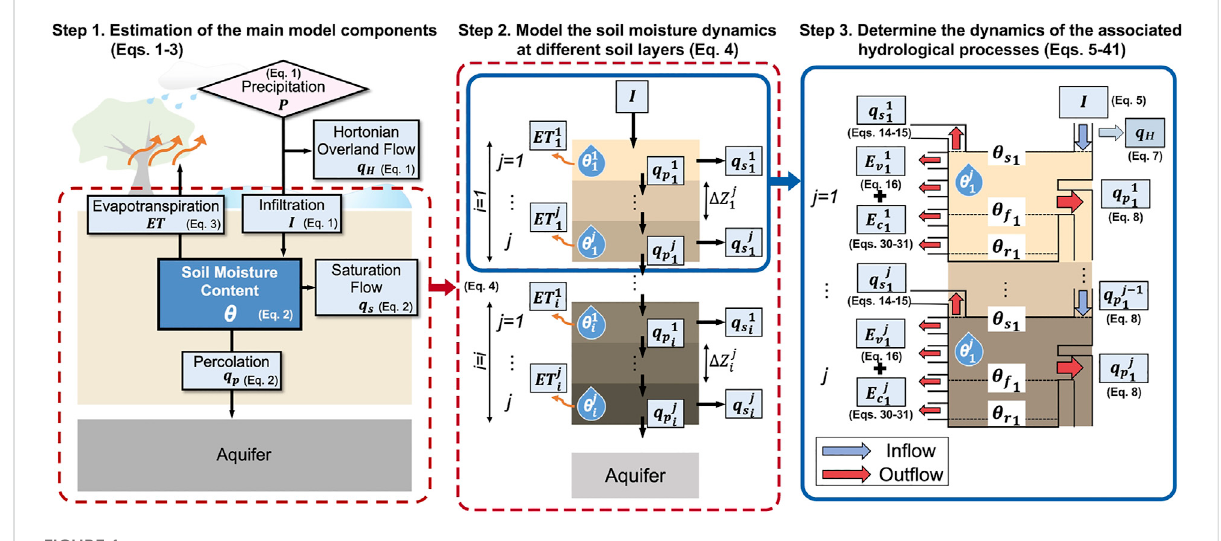
FIGURE 1 A schematic diagram showing the modeling procedures to estimate the shallow soil moisture content ( θ ) based on the mass balance, starting from the water sources of precipitation ( P ), to the various hydrological processes of the Hortonian overland fl ow ( q H ), in fi ltration ( I ), evapotranspiration ( ET ), saturation fl ow ( q s ), and percolation ( q p